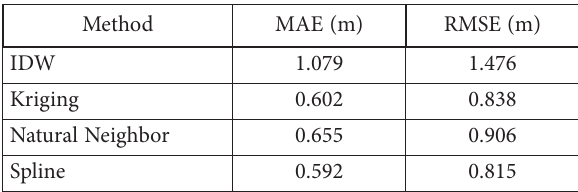
Table 3. Results on MAE and RMSE